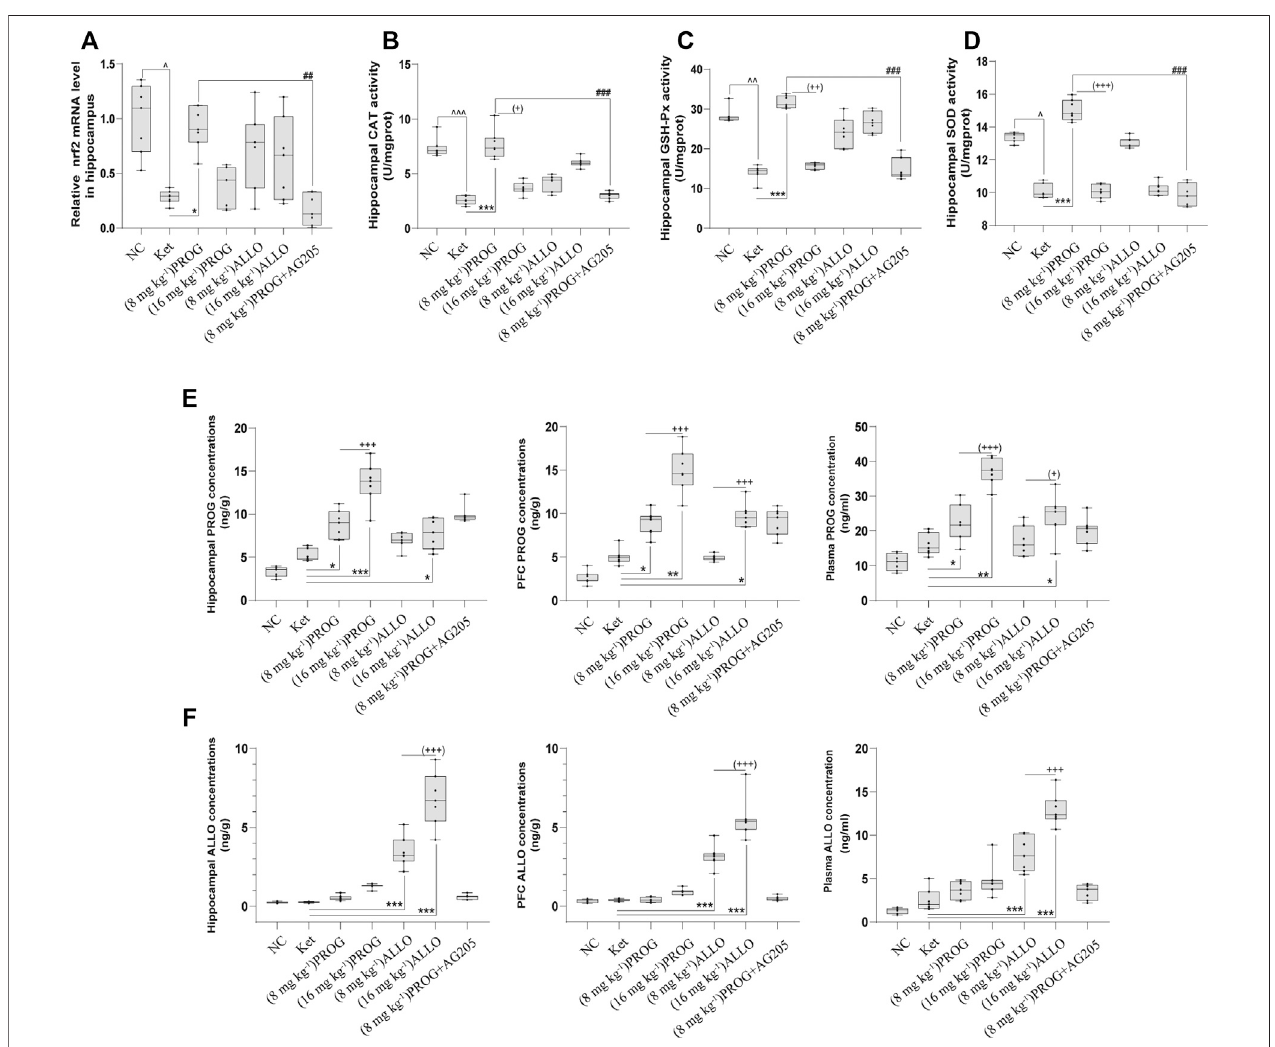
FIGURE5| HippocampalNrf2mRNAexpressionandtheenzymeactivityofCAT,SOD,GSH-PxandtheconcentrationsofPROGandALLOinhippocampus,PFC andplasma. (A) Nrf2, (B) CAT, (C) GSH-Px, (D) SOD, (E) PROGconcentrations, (F) ALLOconcentrations.* p < 0.05, ** p < 0.01and *** p < 0.001foradd-onofPROGand ALLO vs. Ket. + p < 0.05, ++ p < 0.01 and +++ p < 0.001 for PROG (16 mg kg − 1 ) vs PROG (8 mg kg − 1 ) and ALLO (16 mg kg − 1 ) vs. ALLO (8 mg kg − 1 ).